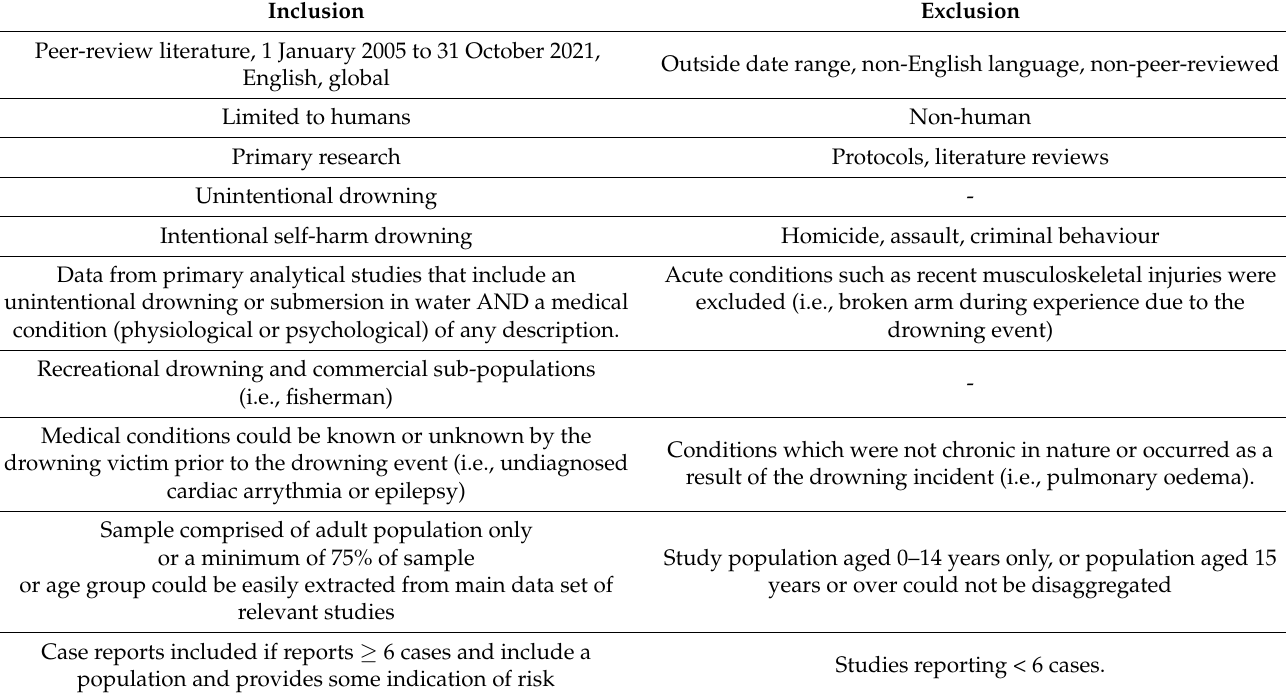
Table 1. Inclusion and exclusion criteria.